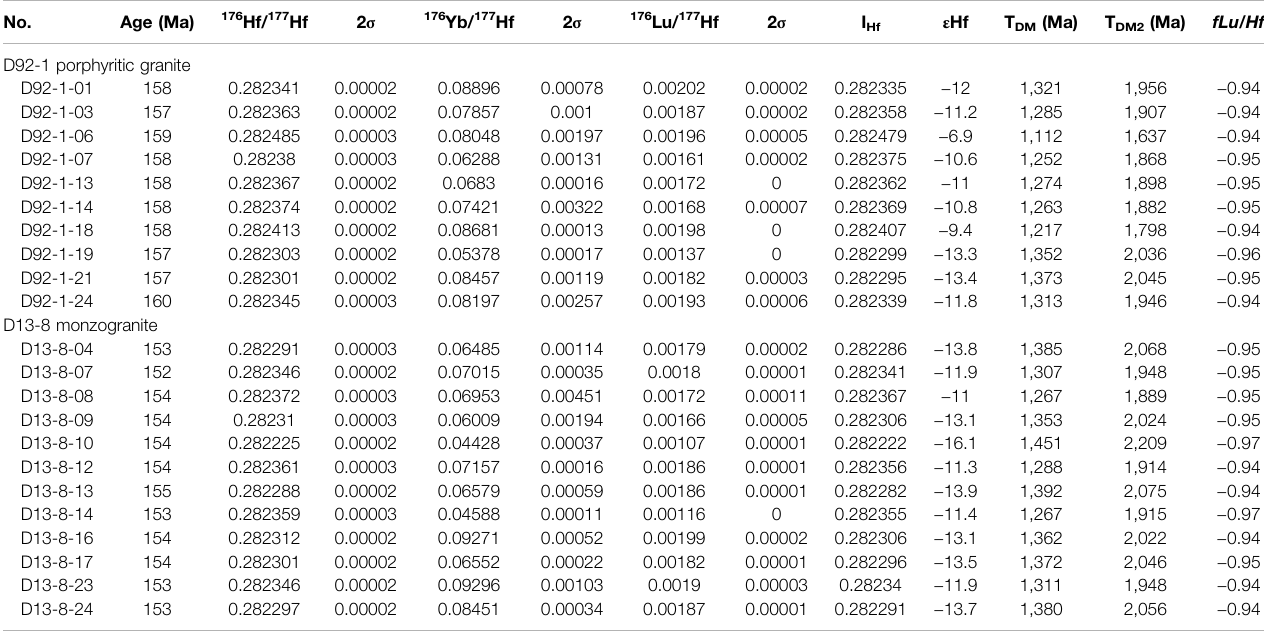
TABLE 2 | Zircon Lu-Hf isotope results in Yaozhuang stock.